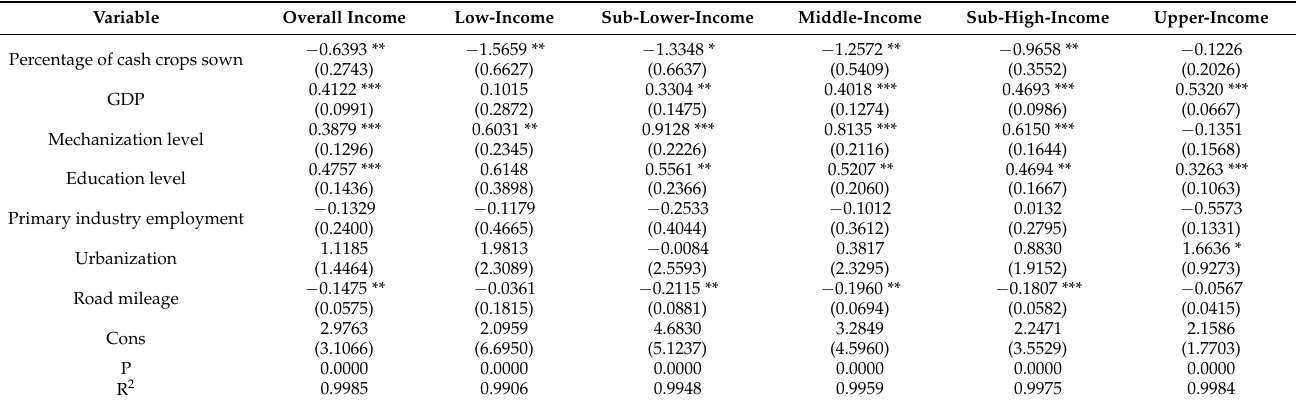
Table 3. Impact of non-food cultivation on the household income of farm households in different income